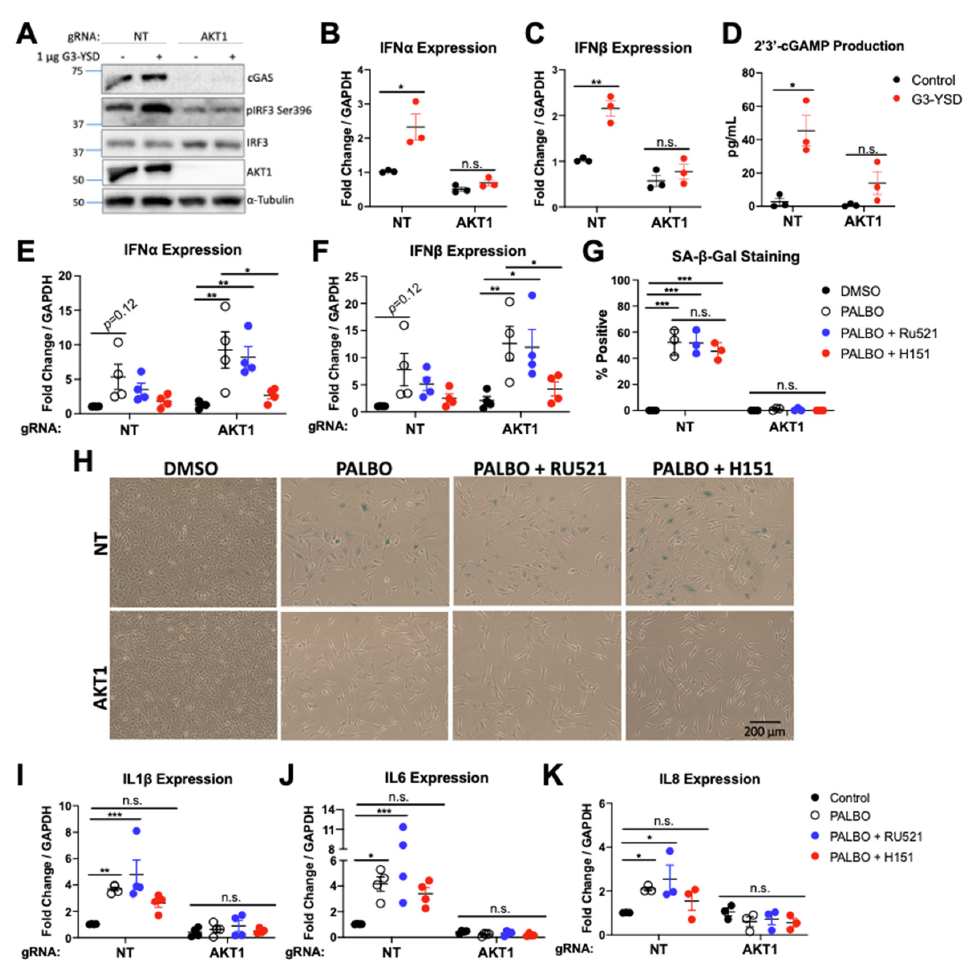
Figure 3. AKT1 is required for cGAS/STING function independent of Palbociclib-induced senescence. ( A ). Western blot of cGAS and IRF3 phosphorylation 48 h after transfection with 1 µ g/mL dsDNA (G3-YSD). ( B , C ). Induction of IFN α / β by RT-qPCR 48 h after transfection with G3-YSD. ( D ). ELISA for 2 ′ 3 ′ -cGAMP from lysates of transfected cells. ( E , F ). Induction of IFN α / β by RT-qPCR after 7 days of treatment with Palbociclib (PALBO) at 1 µ M, PALBO with cGAS inhibitor (Ru521) at 2.5 µ M, or PALBO with STING inhibitor (H151) at 5 µ M ( G , H ). Beta-galactosidase staining of cells treated for 7 days with PALBO (1 µ M) alone or in combination with cGAS inhibitor Ru521 (2.5 µ M) or STING inhibitor H151 (5 µ M). ( I – K ). SASP induction after treatment with PALBO and cGAS/STING inhibitors. Error bars represent SEM. Significance determined by Student’s t -test (Panel ( B – D )) or two-way ANOVA with multiple comparisons (Panel ( E – K )) (* = p < 0.05, ** = p < 0.01, *** = p < 0.001, n.s. = no significance). The uncropped blots are shown in Supplementary